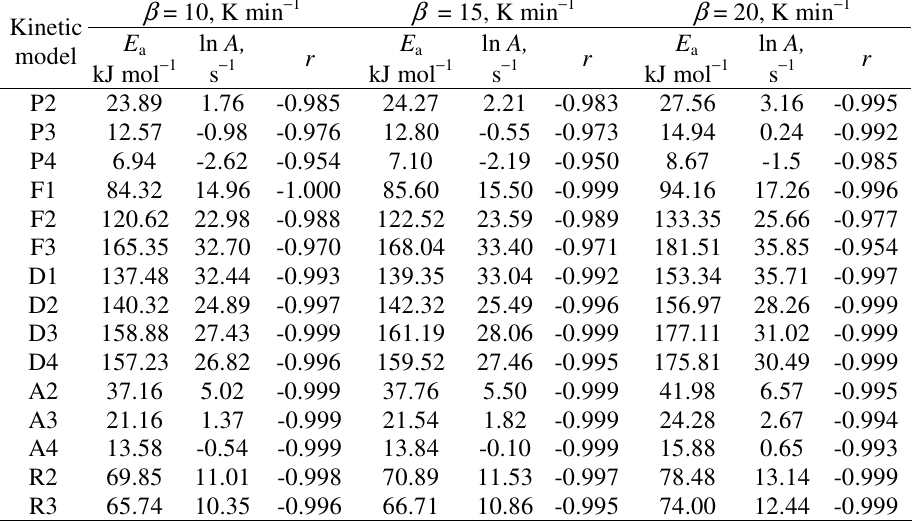
Table 3. Kinetic parameters for the second stage decomposition of HBAPPA